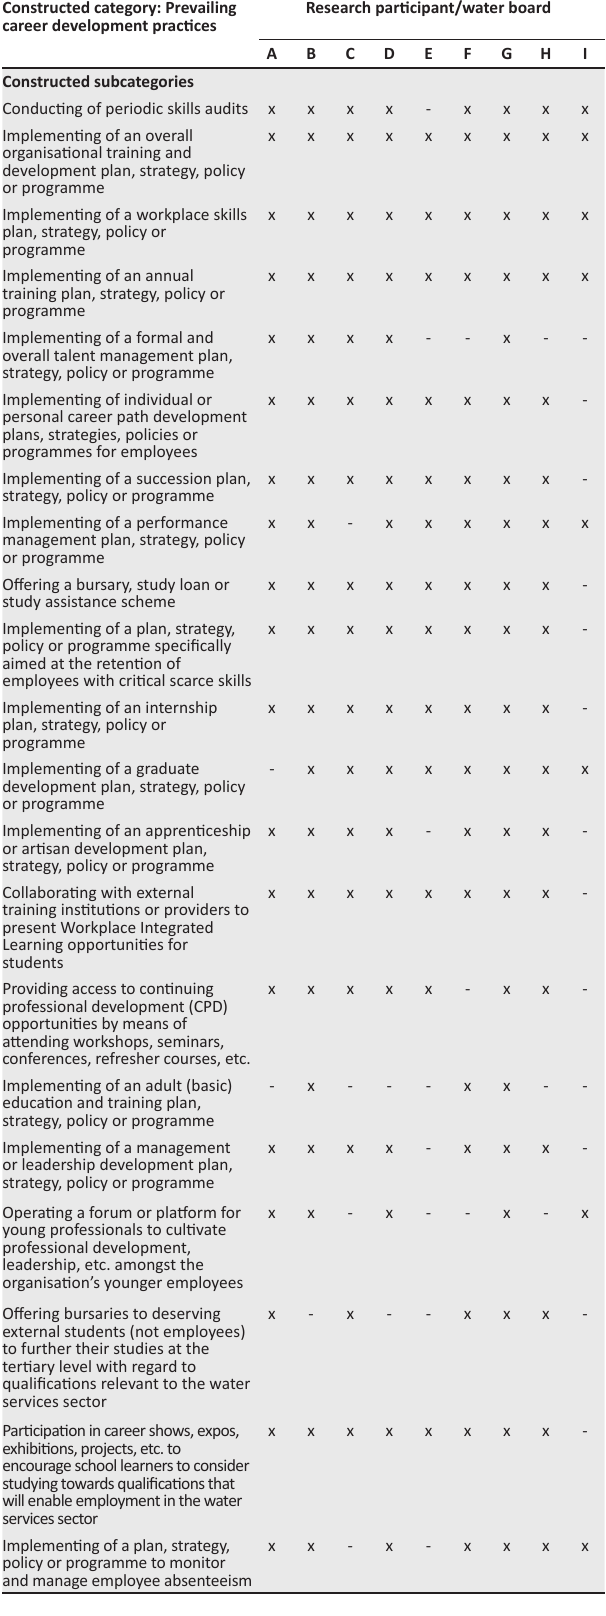
TABLE 5: Focused coding for career development